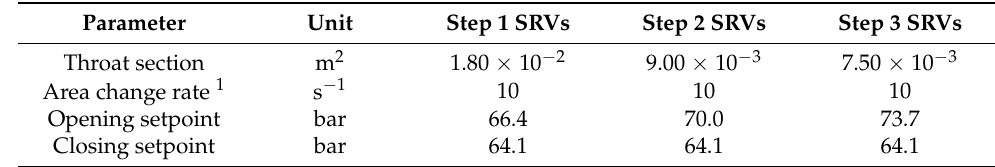
Figure 6. Example of ring nodalization, FW hot ring. The component connections with the sector collectors and loop hot legs are reported. Table 1. Power Conversion System (PCS) steam line Safety Relief Valves (SRV)